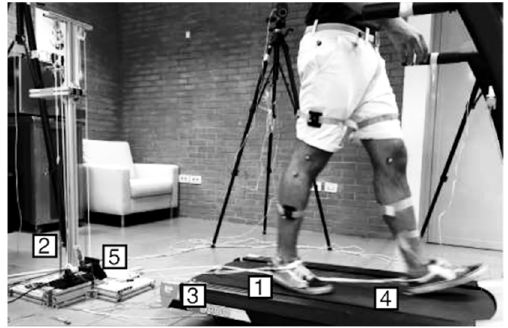
Figure 1. This picture provides an overview of the experimental setup. Labelled components are: 1. Foot being perturbed; 2. Perturbing platform; 3. Treadmill; 4. Unperturbed foot; 5 Cam- braking